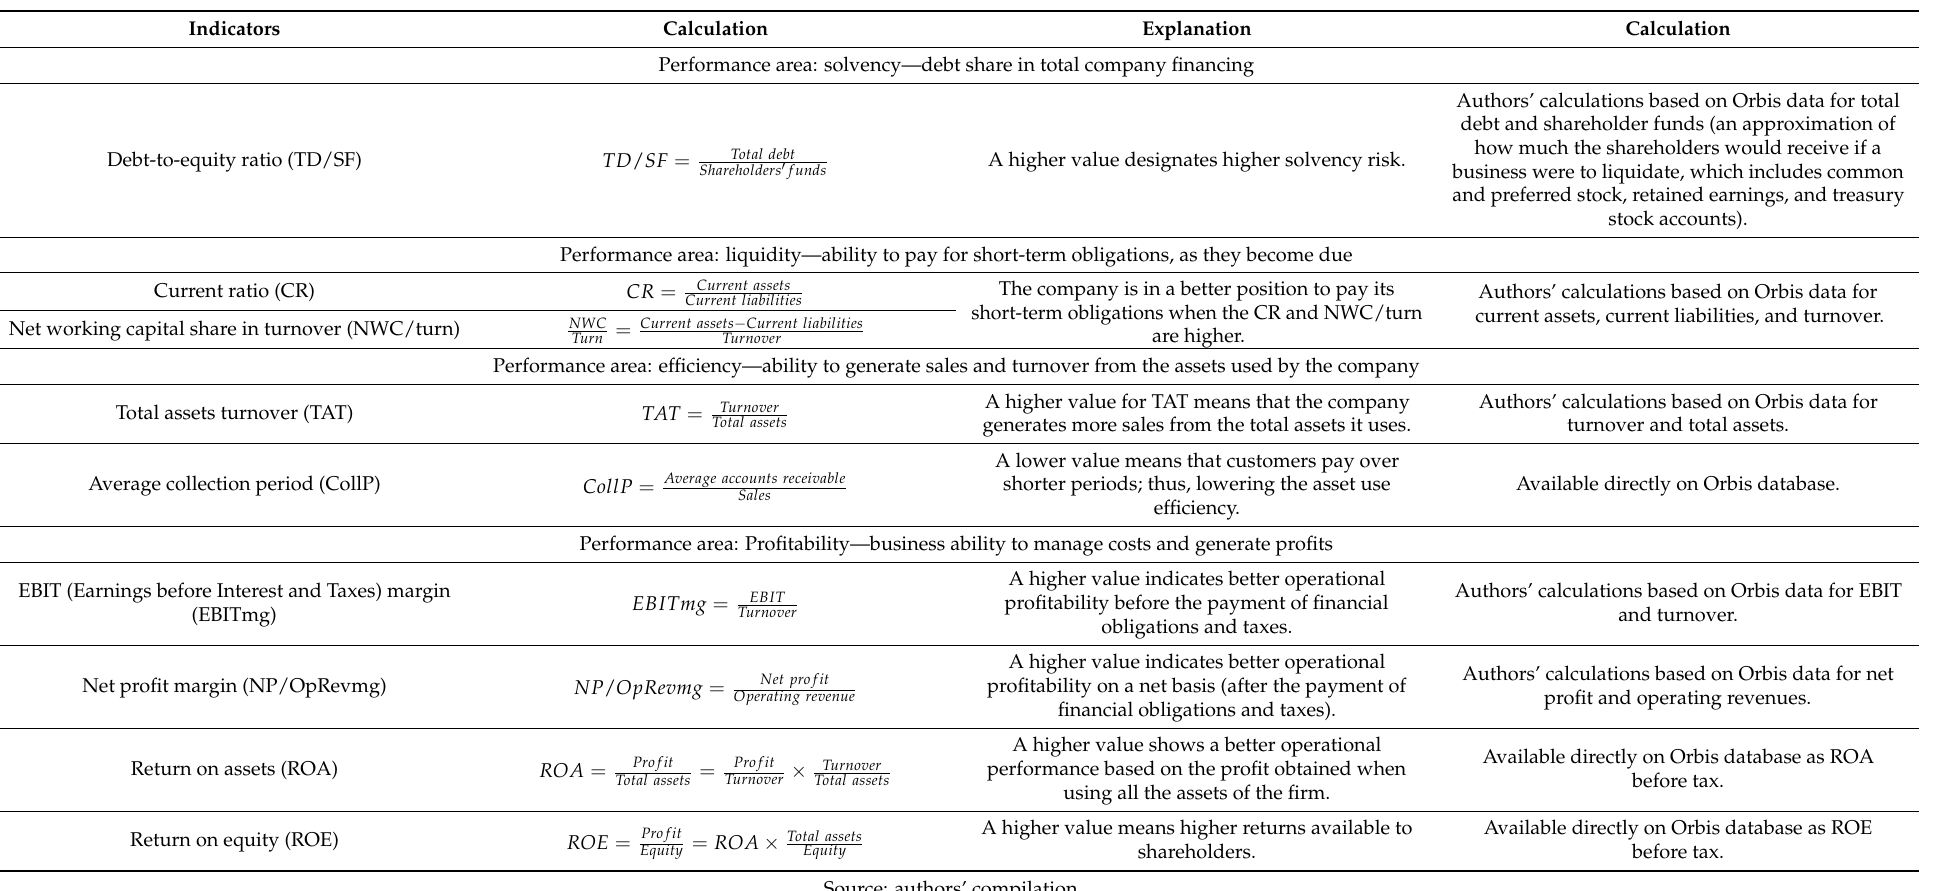
Table 1. Financial indicators used in analysis—brief